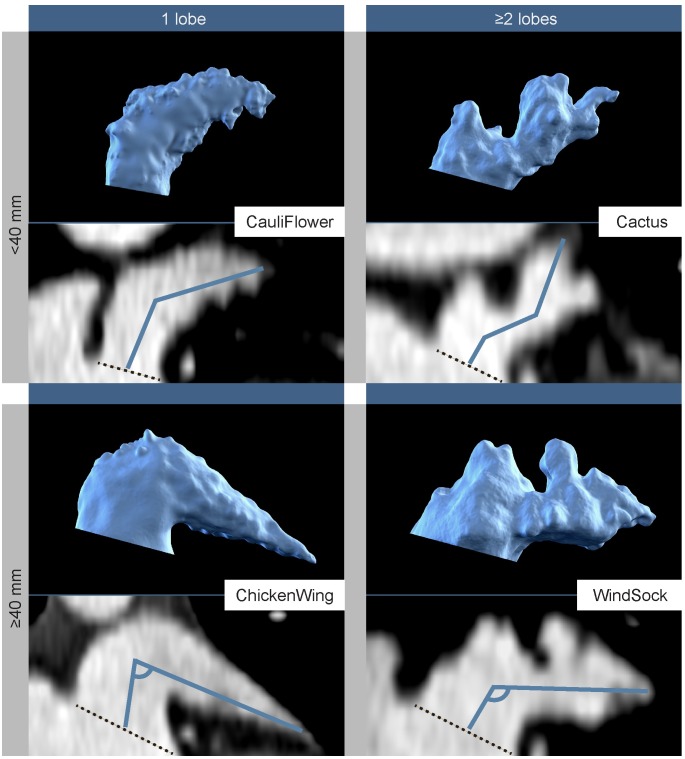
Morphological categories of the Left Atrial Appendage (LAA), as based on Wang’s classification with Kimura’s quantitative qualifiers.The dashed line at the LAA orifice represents the base line from which quantitative measurements were made. The blue line indicates how LAA length and bend angle were derived. Differences between the ChickenWing (<100-degrees) and WindSock category (>100-degrees) are also based on the angle at the proximal part of the LAA.